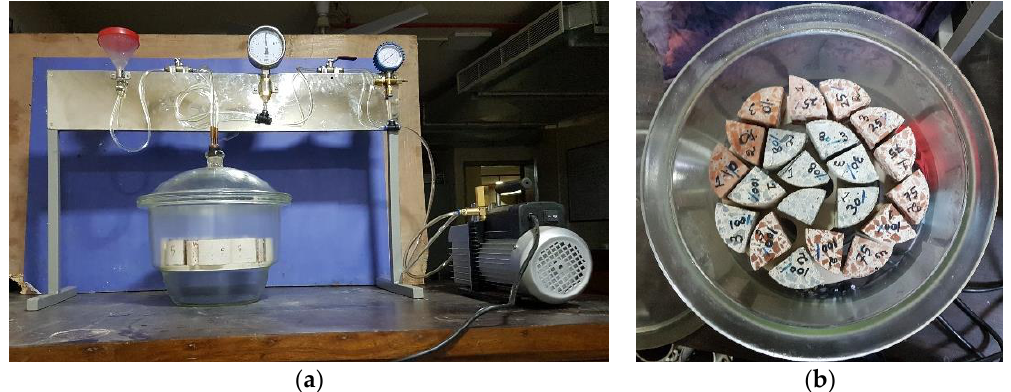
Figure 4. Test setup for porosity according to the French standard NF P18-459 [28] ( a ) and specimens for porosity test ( b ).